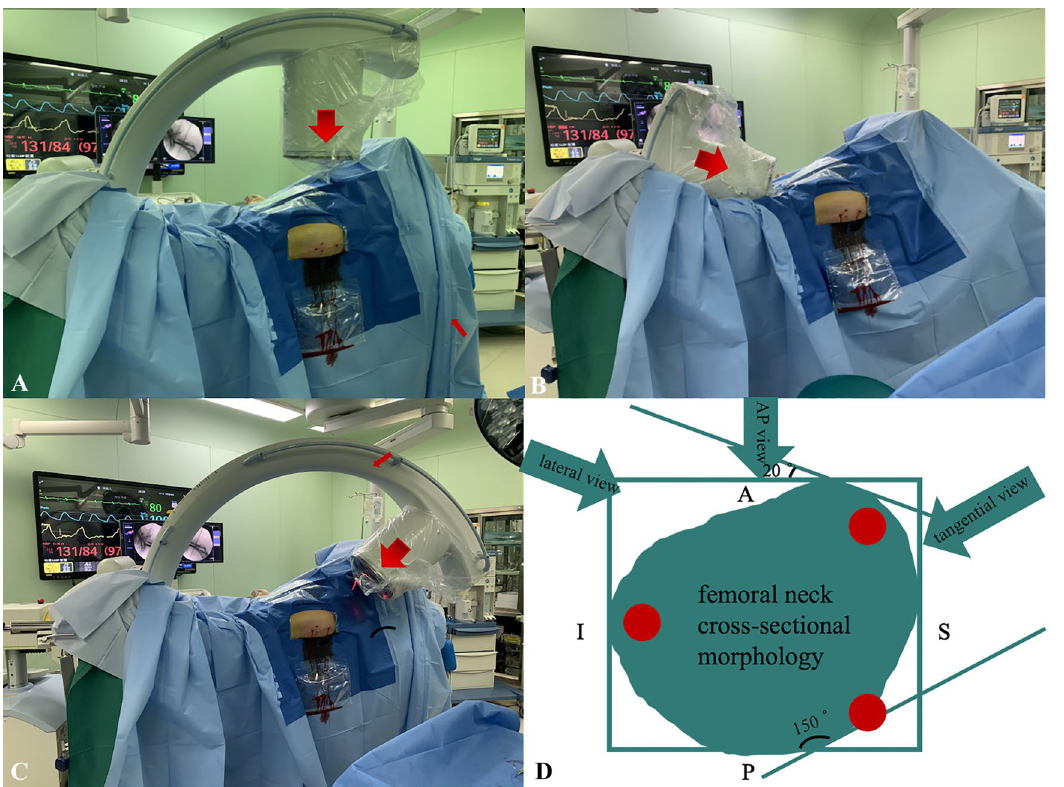
Figure 2. ( A ) Positioning of C-arm during the standard femoral neck AP view, ( B ) positioning of C-arm during the standard femoral neck lateral view, ( C ) positioning of C-arm during the 150° tangential views, ( D ) the red circles represent femoral neck screws, the green oblique oval represents the femoral neck